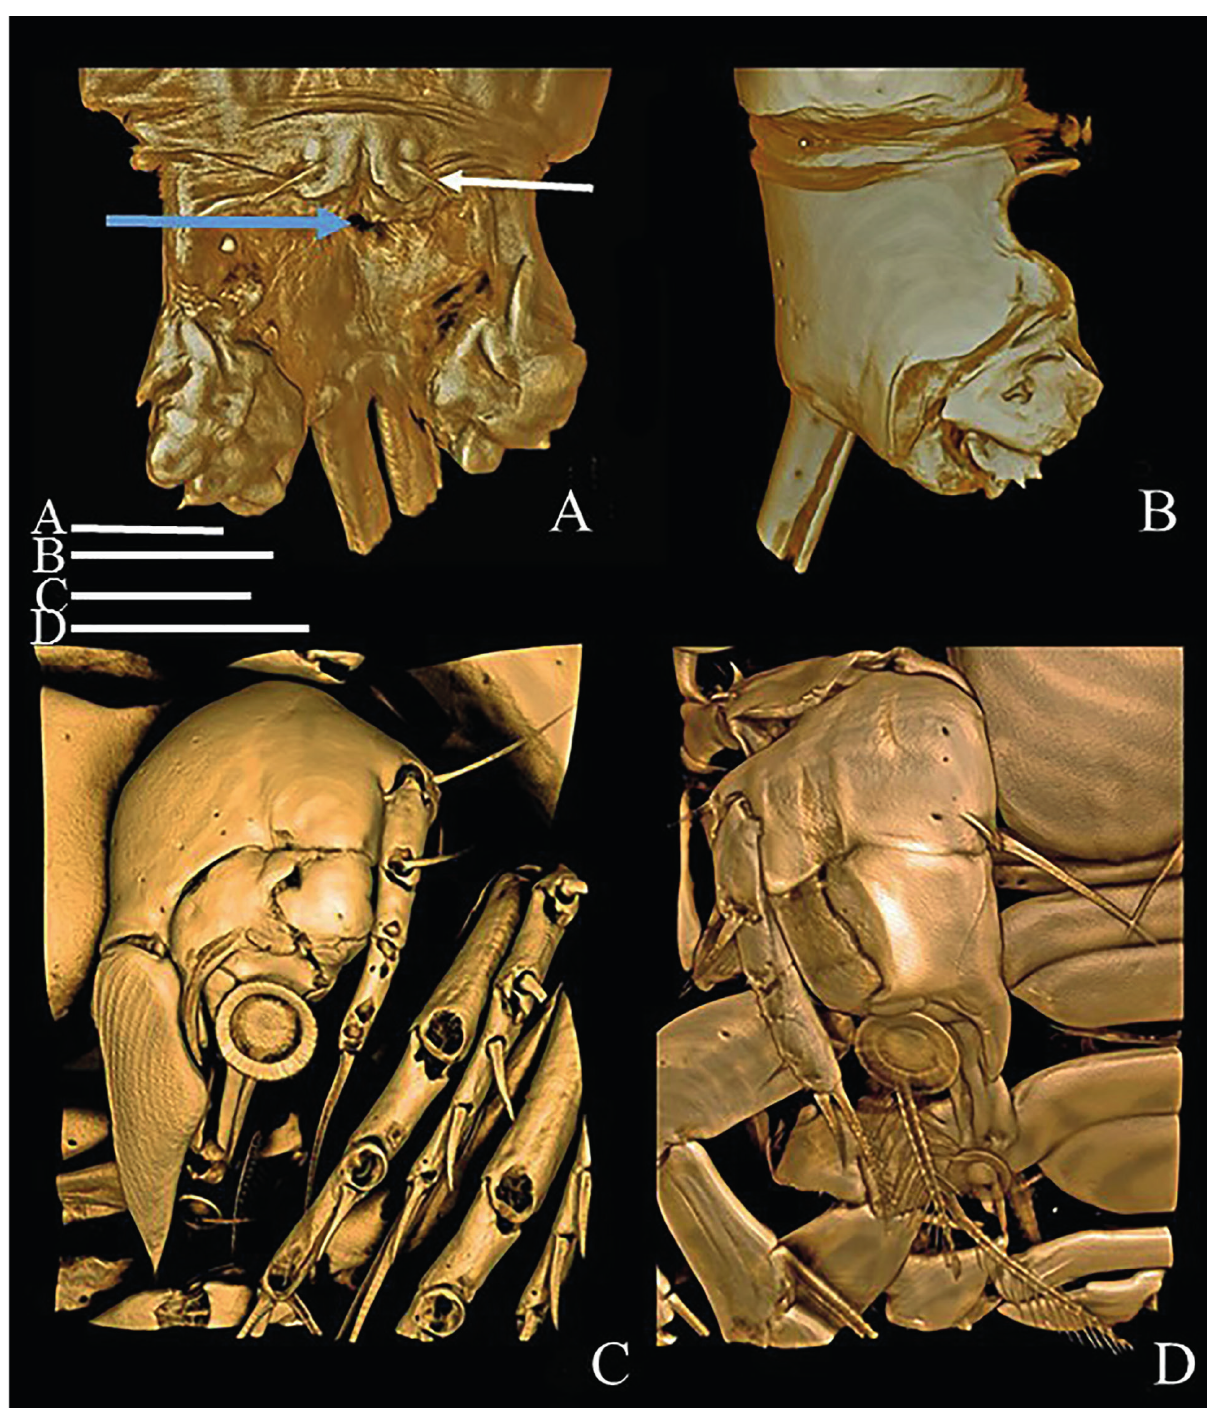
Figure 12. Clausidium persiaensis sp. nov. Three-dimensional representation (Drishti software) based on confocal laser scanning microscopy images. A, anal somite, dorsal (female); B, anal somite, lateral (female); C, P1 (female); D, P1 (male). Blue arrow = medial pore; white arrow = genital apertures. Scale bars: 50